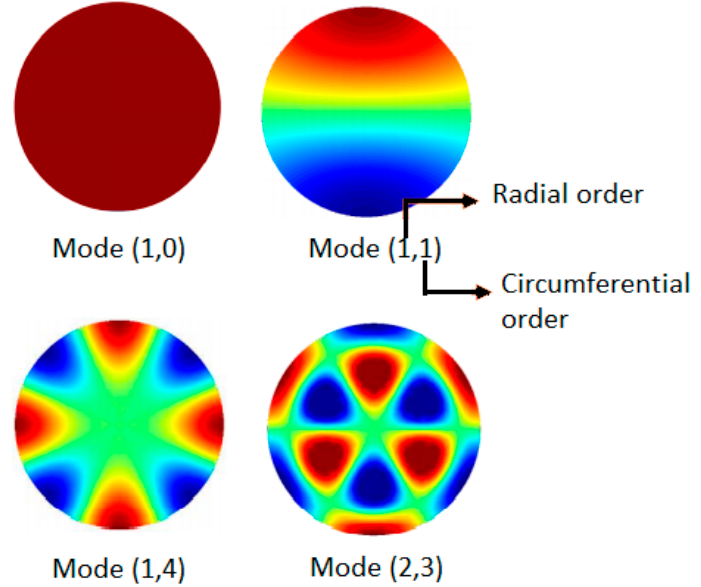
Figure 4. Example of acoustic mode shapes in circular ducts. The duct modes follow an analytical representation of a semi-infinite duct (i.e., plane wave propagation with no reflection at the boundaries) that does not need to be meshed (Figure 5). This approach simulates the excitation at the inlet with imposed duct modes and the anechoic condition with free duct modes.